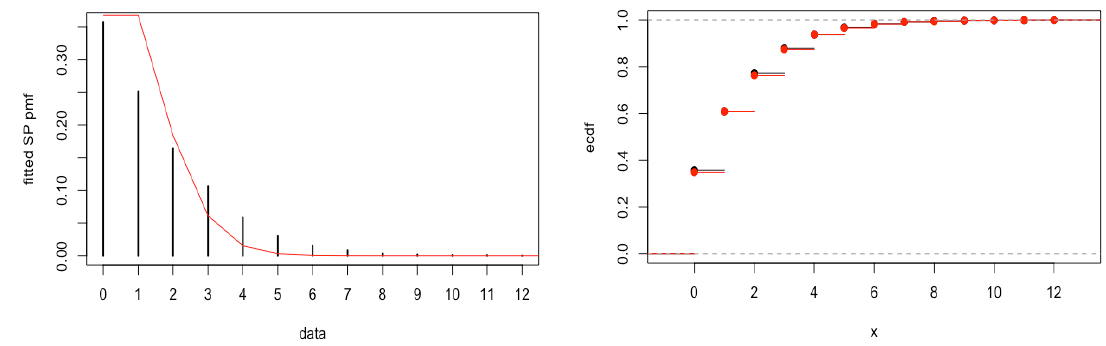
Figure 5. Fitted pmf plot ( left ) and ecdf plot ( right ) for the insurance claims data.